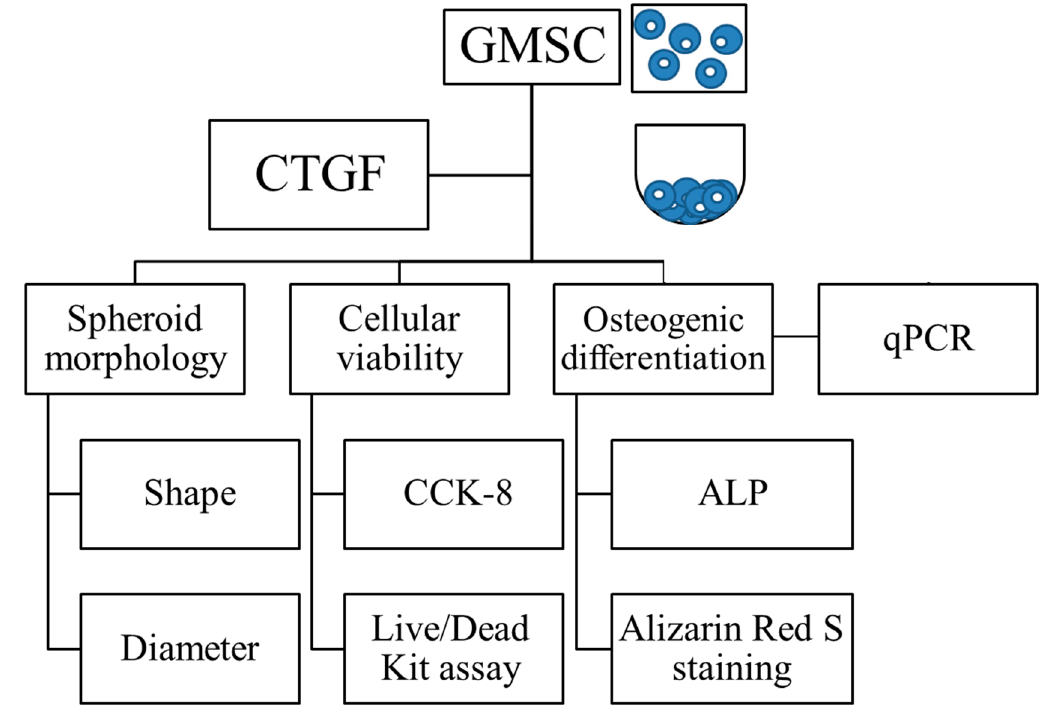
Figure 1. Study flow diagram illustrating the overview.